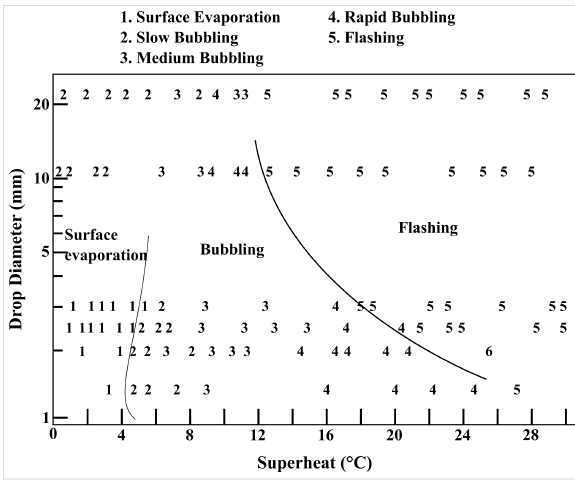
Figure 2: Empirical diagram of the evaporation of a water drop, adapted from